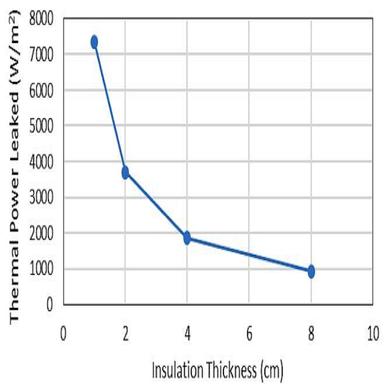
Thermal power conducted into the irradiation channel from reactor as a function of insulation thickness.